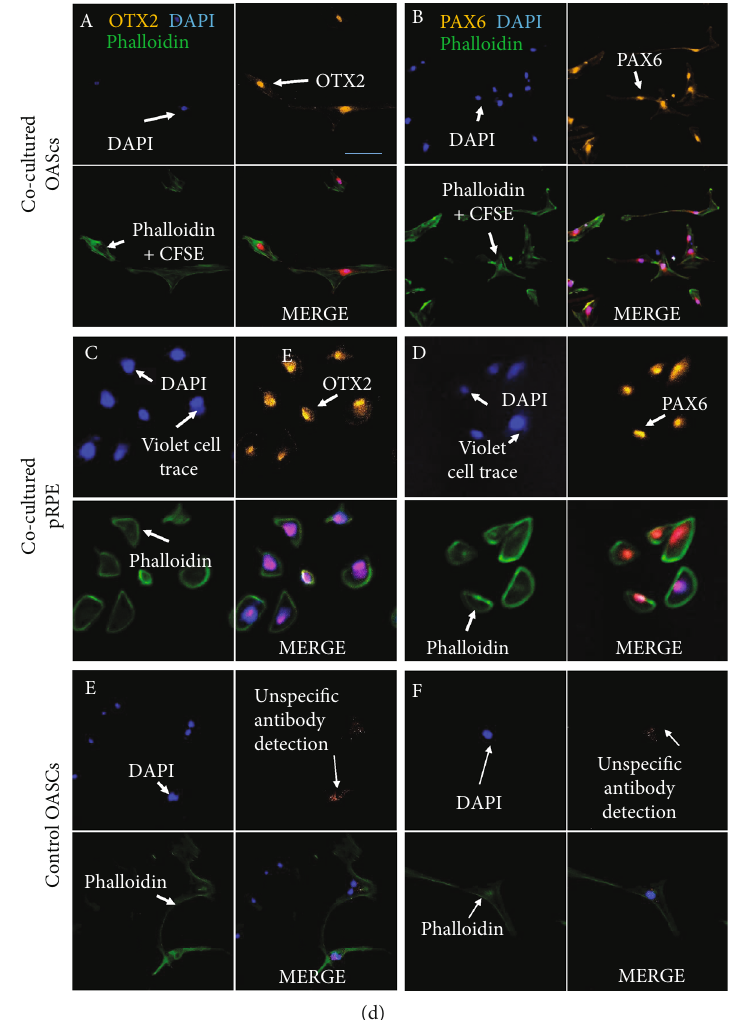
Figure 3: Di ff erentiation of OASCs to RPE like cells. (a, b) Coculture of p-RPE cells and OASCs. (a) Prestaining of cells: OASCs were marked with CSFE (green color), and RPE mature cells were marked with Violet Cell Trace (blue color). (b) FACS sorter: three distinct populations are de fi ned after coculture: RPE cells, OASCs and OASCs, and RPE cells which were fused together. Auto fl uorescent cells were excluded according to negative and positive controls of labeled cells. (c) Evidence of di ff erentiation of OASCs to RPE like cells by RT-qPCR. Results are presented as mean increase ± SD relative to sample plot. After coculture with RPE cells, OASCs exhibited an increase in transcription of early and late RPE markers. (d) Evidence of di ff erentiation potential of OASCs by immuno fl uorescence. (A) Sorted OASCs derived RPE-like cells labeled with CFSE showing nuclear localized OTX2 expression. (B) Sorted OASCs derived RPE-like cells showing nuclear localized PAX6 expression (C) Positive control of sorted RPE cells in Violet Cell Trace showing nuclear localized OTX2 expression. (D) Positive control of sorted RPE cells in Violet Cell Trace showing nuclear localized PAX6 expression. (E, F) Negative control of OASCs that did not show any OTX2 expression or PAX6 expression. CT: cell trace. Scale bar: 100 μ m. n = 3